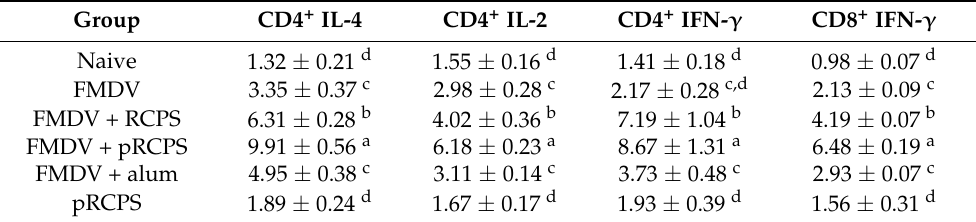
Table 1. Effects of the pRCPS on cytokine production in T cells by FACS (%). Group